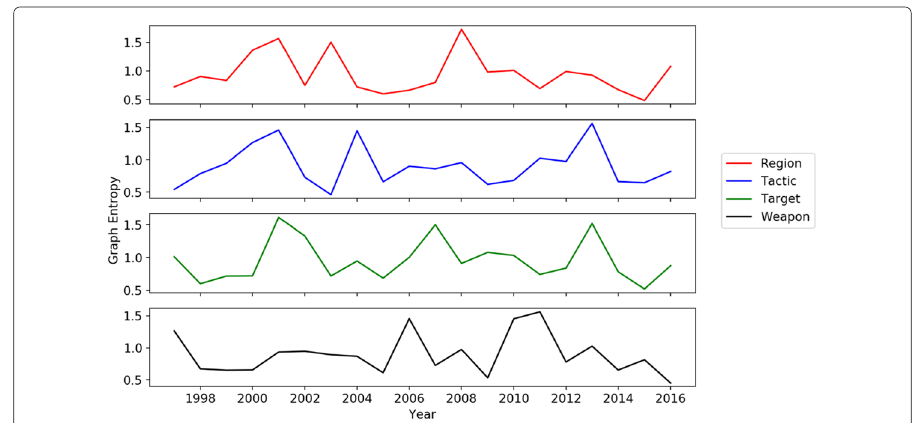
Fig. 8 Entropy variation for each mode